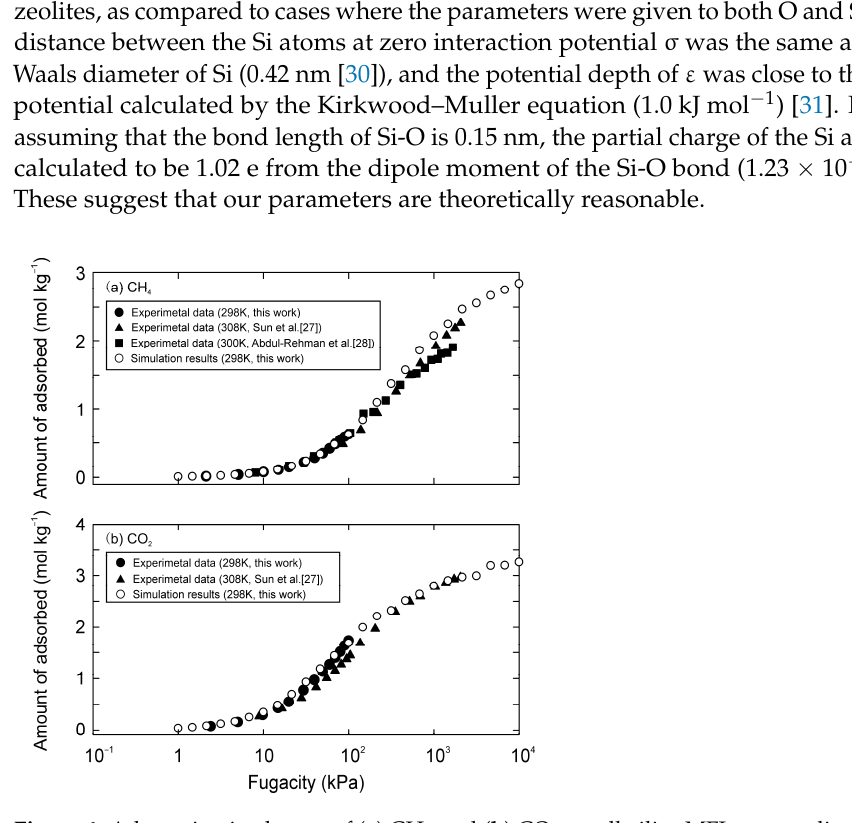
Figure 4. Adsorption isotherms of ( a ) CH 4 and ( b ) CO 2 on all-silica MFI-type zeolite around 300 K.